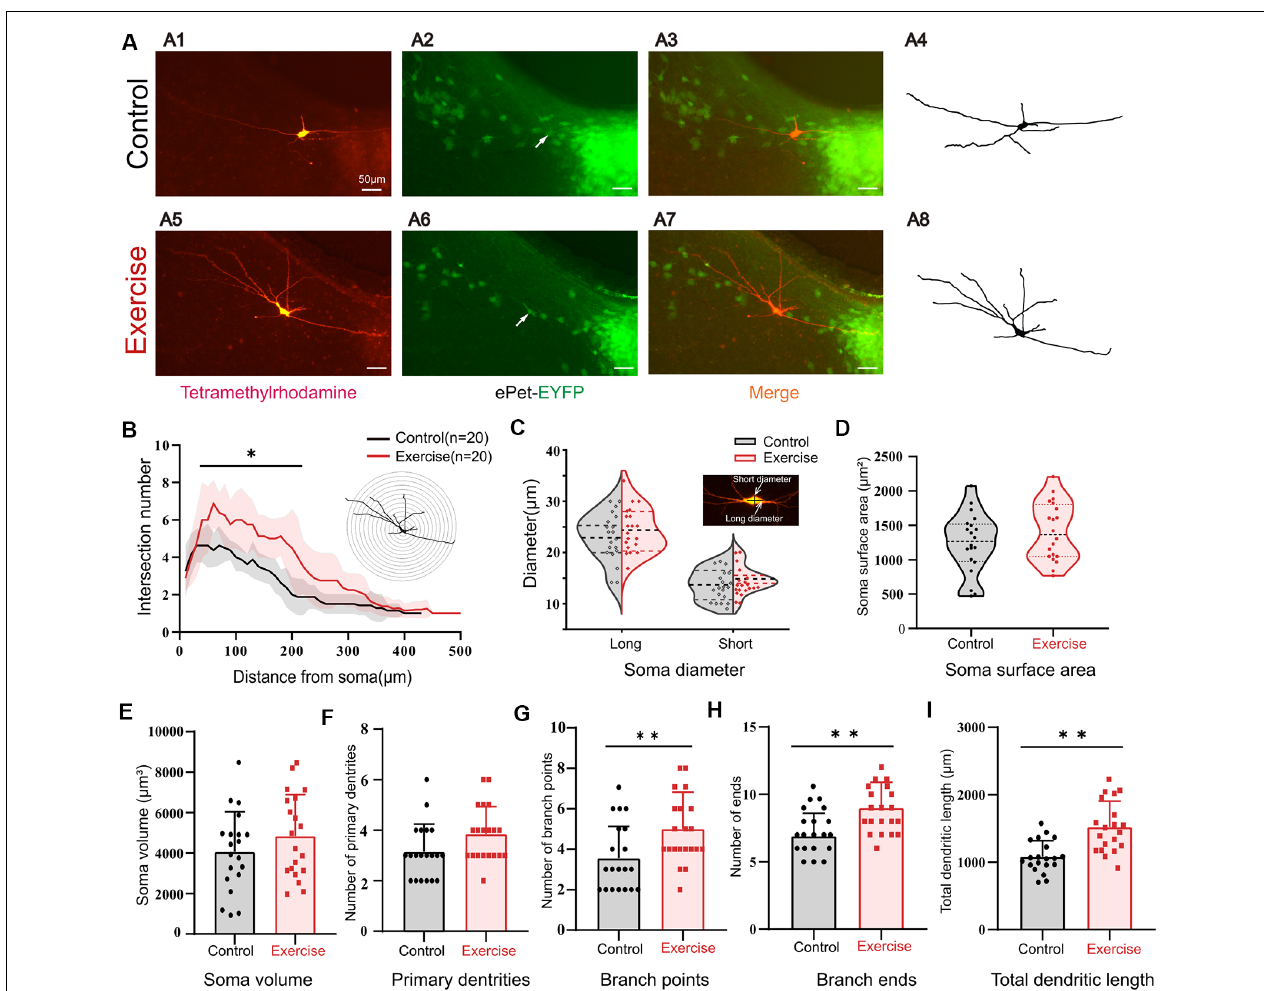
FIGURE 7 | Treadmill exercise facilitated dendritic plasticity. (A) Example of exercise training increased the number of dendrites; (A1) fluorescence image of staining of tetramethylrhodamine in control group; (A2) fluorescence image of EYFP-positive neurons; (A3) merged image of (A1) and (A2) ; (A4) neuronal morphology diagram reconstructed with Sholl analysis in (A1) ; (A5) fluorescence image of staining of tetramethylrhodamine in exercise group; (A6) fluorescence image of EYFP-positive neurons in the exercise group; (A7) merged image of (A5,A6) ; (A8) neuronal morphology reconstructed with Sholl analysis in (A5) . (B) The illustration at the top right is an example of Sholl analysis, in which a series of concentric circles around the soma were created and then counted times the dendrite intersecting the circle (intersections) as well as the length of each dendritic arbor segment within each radius. The number of intersections in the range of 50–200 µ m from the soma increased significantly in the exercise group; ( p < 0.05). (C) Most 5-HT cell bodies were fusiform, so we measured the long and short diameters of the cell bodies as shown in the illustration at the top right. Exercise training had little effect on neuron diameters (short diameter: p = 0.214, long diameter: p = 0.311). There were no significant changes in soma surface area ( D , p = 0.232), soma volume ( E , p = 0.229), and number of primary dendrites ( F , p = 0.054) between two groups. Exercise training significantly increased the number of branch points ( G , p = 0.009), number of ends ( H , p = 0.001), and total dendritic length ( I , p < 0.001). ∗ p < 0.05, ∗∗ p <